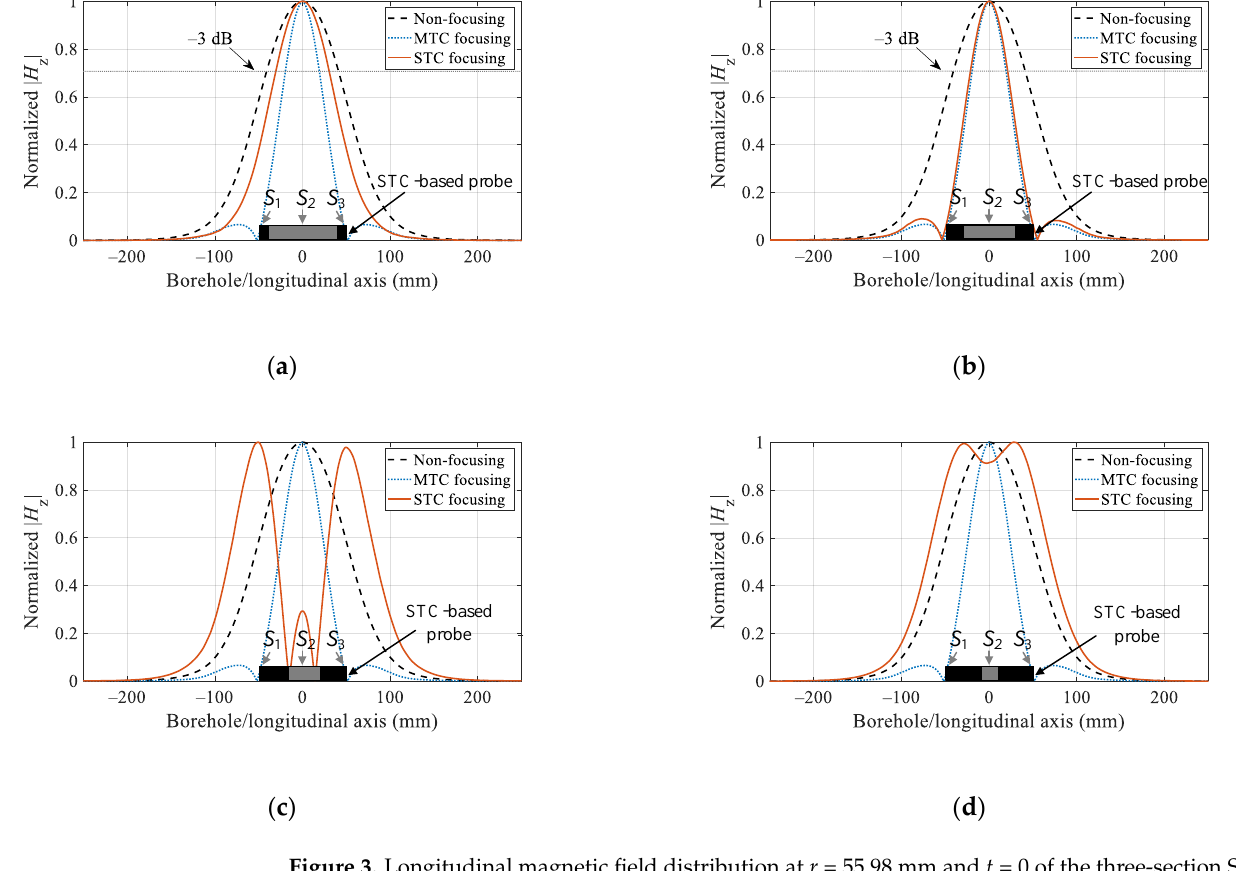
Figure 3. Longitudinal magnetic field distribution at r = 55.98 mm and t = 0 of the three-section STC: ( a ) n 2 = 240, ( b ) n 2 = 180, ( c ) n 2 = 120, and ( d ) n 2 = 60.